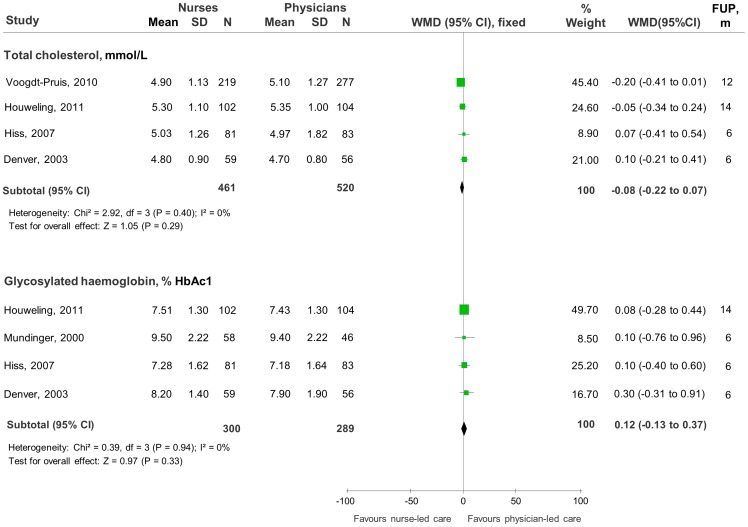
Comparison of total cholesterol and glycosylated haemoglobin control between nurse-led care and physician-led care.Studies are listed in order of decreasing weighted effect size. Abbreviations: mmol/L = millimoles per litre of blood; % HbAc1 = percent of glycosylated haemoglobin (of total haemoglobin); SD = standard deviation; N = total number of patients in the analysis; WMD = weighted mean differences; CI = confidence interval; df = degrees of freedom; I2 = heterogeneity between trials; FUP = Follow-up; m = months.